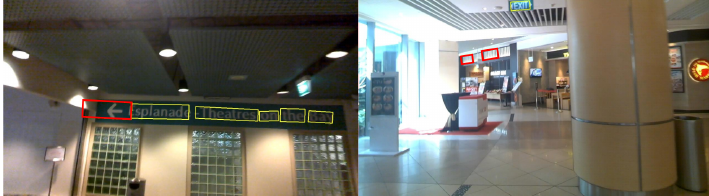
Figure 7. False positive results with the ICDAR2015 dataset, where the red rectangles indicate the failed